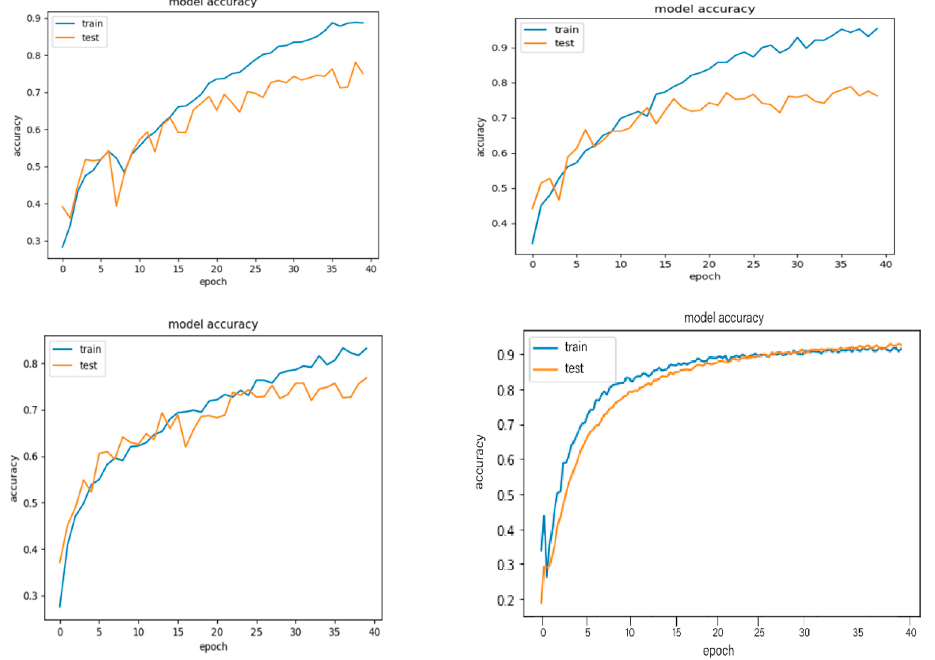
Figure 7. Variation of the accuracy value in the validation set for each model.